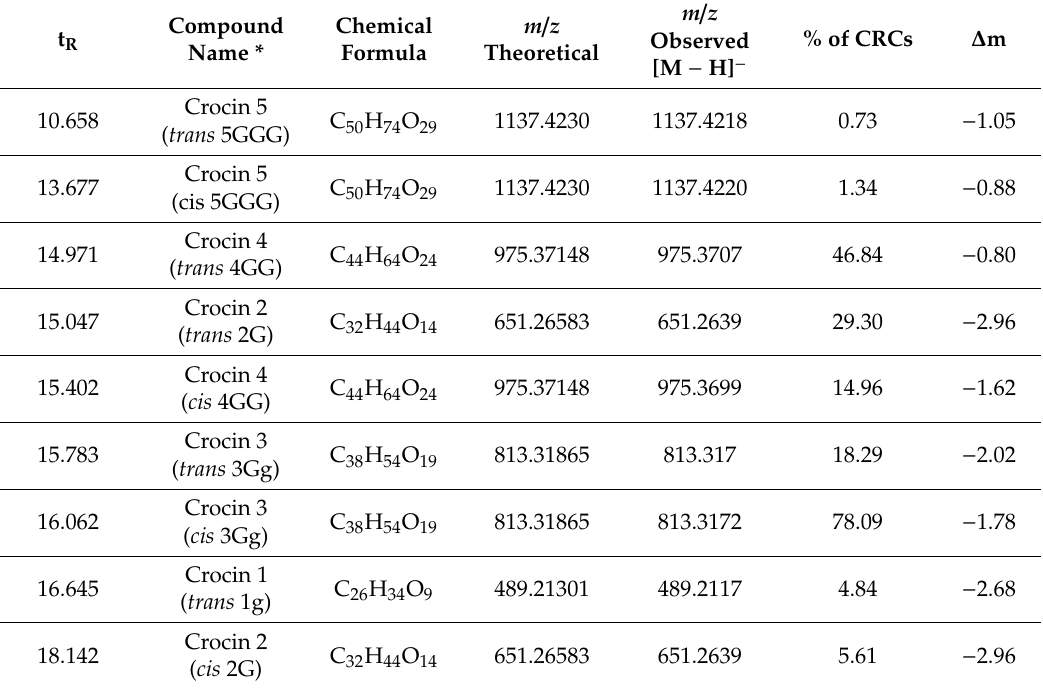
Table 1. Identified compounds at the negative ionization